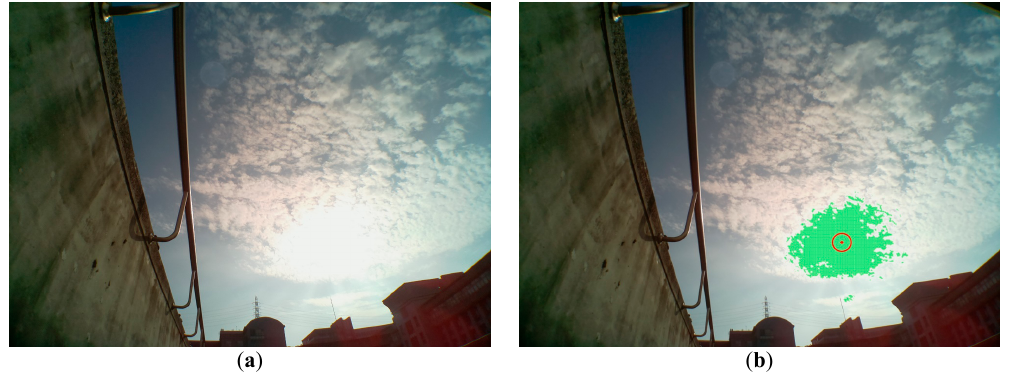
Figure 6. ( a ) The sun is shielded by the cloud; ( b )The evaluated center of the sun by the brightest region method is illustrated as a red point.